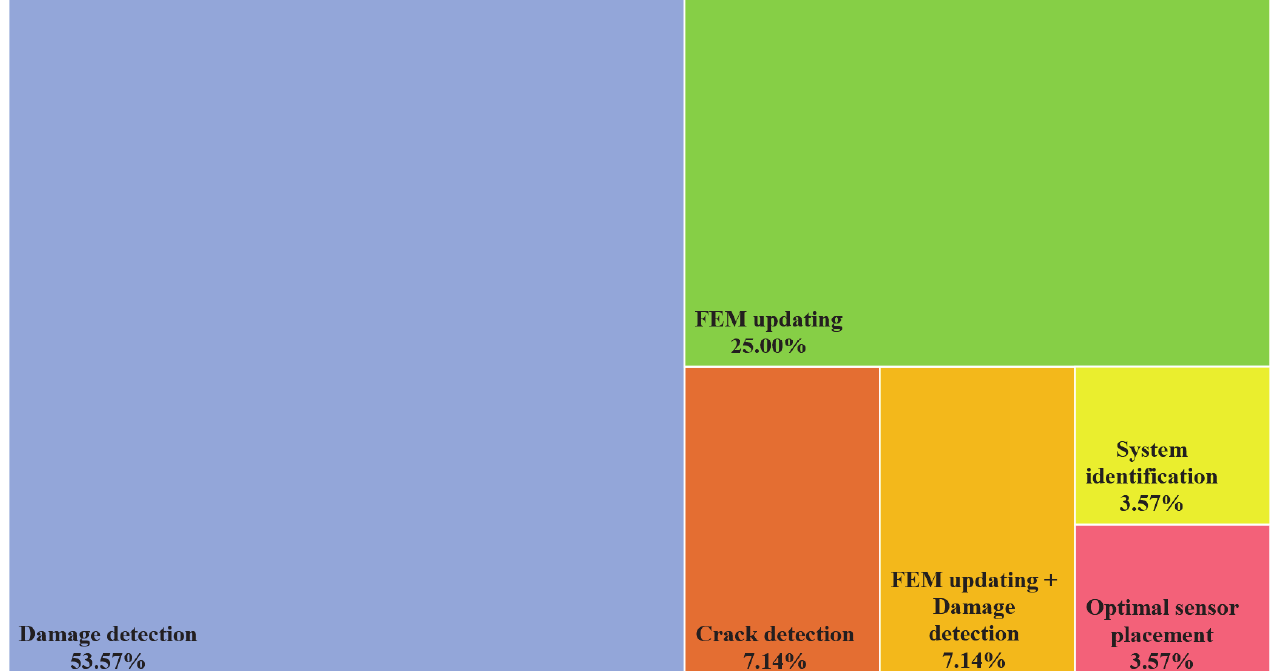
Figure 6: Contribution of the publications in fields of damage detection, FEM updating, crack detection, FEM updating+damage detection, system identification, and optimal sensor